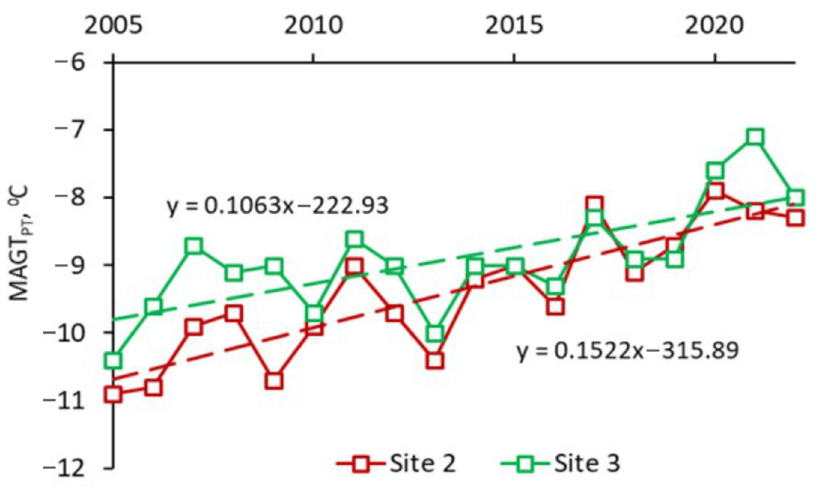
Figure 8. Mean annual temperature at the top of permafrost in the wet tundra areas (Sites 2 and 3), 2005–2022.